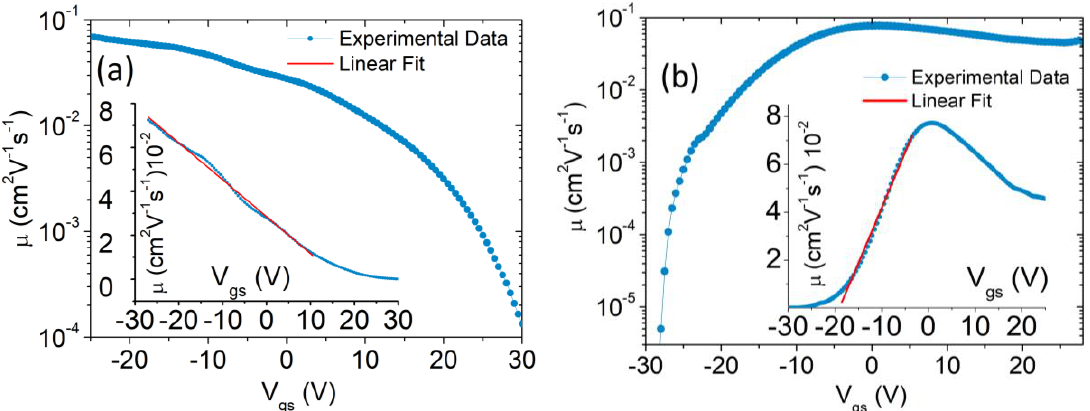
Figure 3. Mobility versus gate voltage on a logarithmic scale for the WSe 2 flake covered ( a ) and uncovered ( b ) by PMMA. The inset graphs show the mobility on a linear scale.